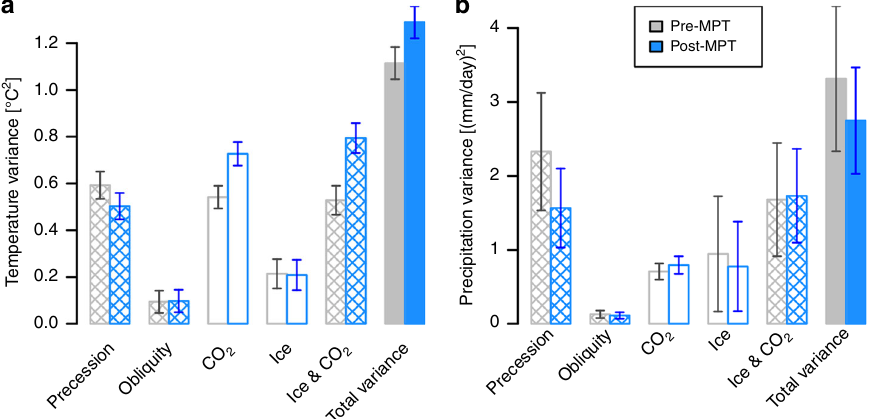
Fig. 9 Sensitivity of temperature and precipitation to astronomical, ice, and CO 2 forcing. a Mean annual temperature (MAT) and b mean annual precipitation (MAP) responses to precession and obliquity, ice, CO 2 , and coupled ice/CO 2 forcing. Temperature and precipitation variances are spited into contributions for precession, obliquity, ice, CO 2 , and coupled ice and CO 2 variation before the MPT (pre-MPT, gray) and after the MPT (post-MPT, blue), respectively. The combined ice/CO 2 contribution is not estimated by simply adding up the individual impacts of ice and CO 2 because their effects can partly cancel out each